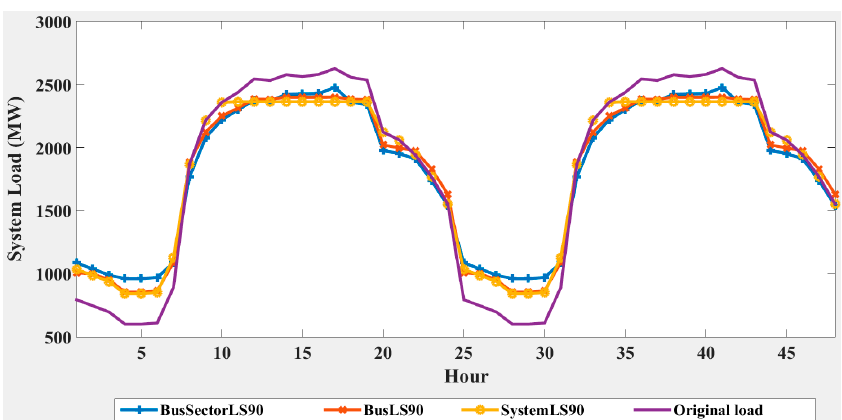
Figure 5. The 48-h system load profile with 85% pre-specified peak.